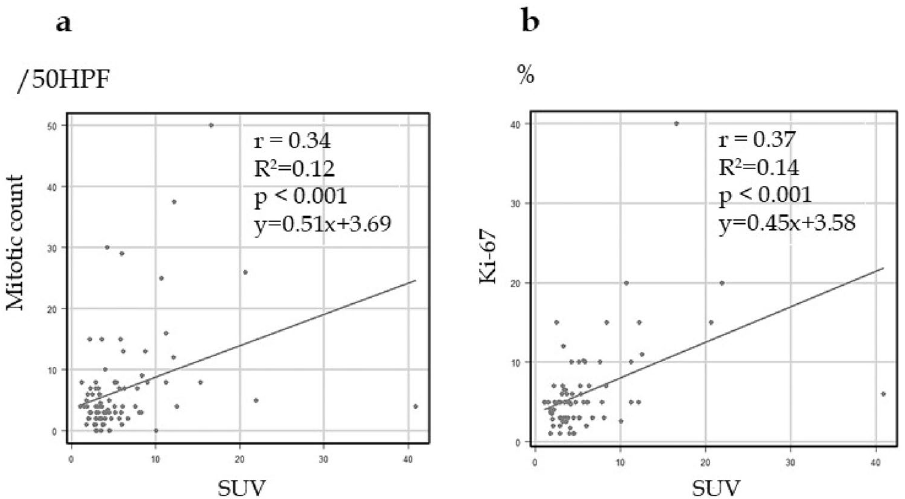
Figure 3. Correlation between SUVmax and mitotic count and Ki-67 of GIST. There was a positive linear relationship between SUVmax and mitotic count and Ki-67. ( a ) Mitotic count. ( b ) Ki-67.